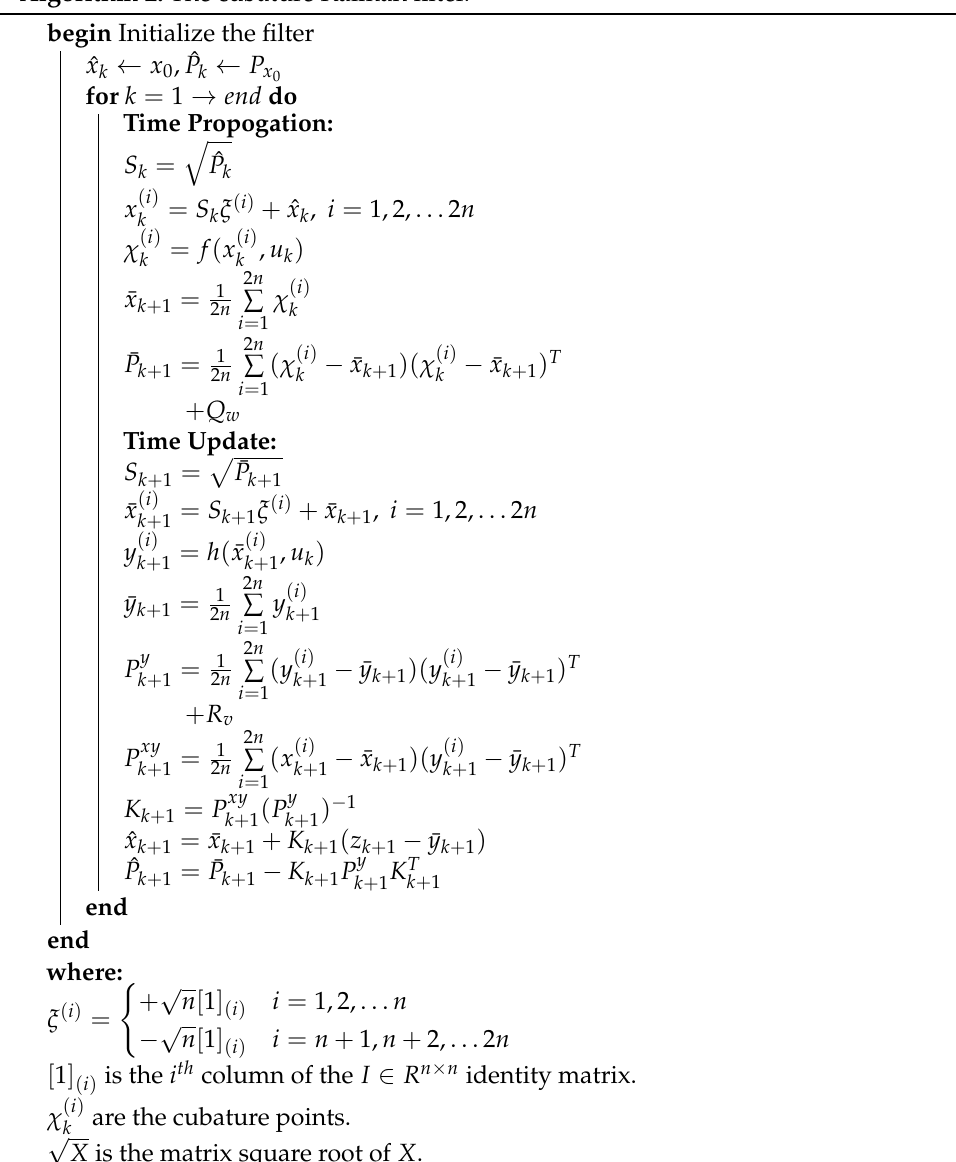
Algorithm 2: The cubature Kalman